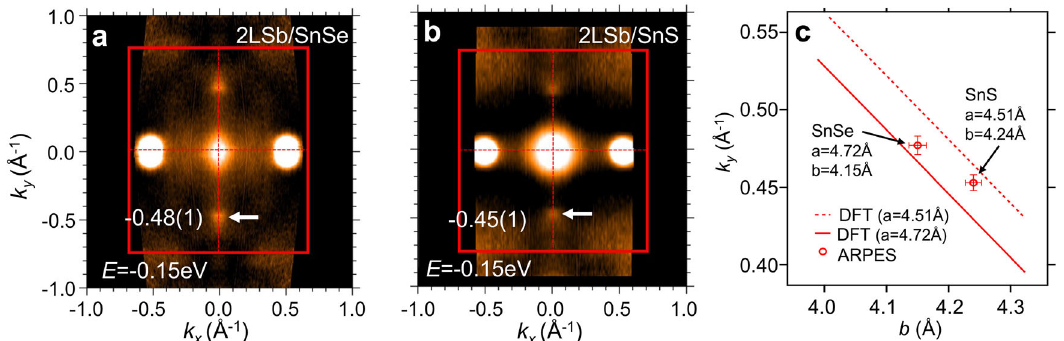
Fig. 6 | ARPES iso-energy contours of 2L Sb fi lms grown on SnS and SnSe showing the unpinned nature of Dirac states. a ARPES iso-energy contour at E = − 0.15eVtakenfromthe2L α -SbsamplegrownonSnSesubstrate.TheDiracpoint ofthe p z bandismarkedbythewhitearrow. b Sameas a ,butfromthesamplegrown